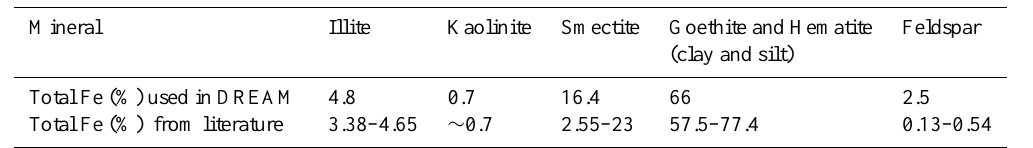
Table 2. Content of total iron in different minerals as used in the model and its range based on values reported in Thomson and Hower, 1975; Journet et al., 2008; Paris et al., 2011.